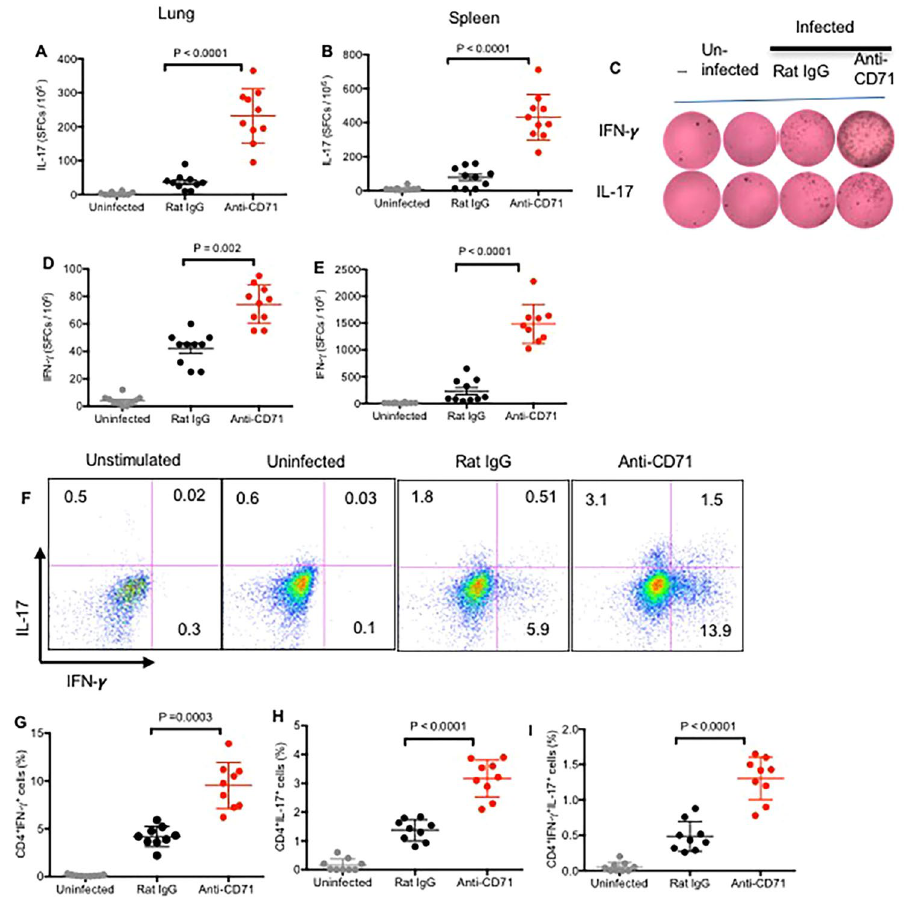
Figure 3. Depletion of CD71 + cells enhances IL-17 and IFN- γ secretion by adaptive immune cells. (A ) Lung cells or ( B ) splenocytes (5 × 10 4 ) from anti-CD71 treated or control mice were stimulated with medium alone or with HKBP for 24 h, IL-17 secreting cells were visualized and enumerated by ELISpot. ( C ) Representative ELISpot images are shown. ( D ) Lung cells or ( E ) splenocytes (5 × 10 4 ) from anti-CD71 treated or control mice were stimulated with medium alone or with HKBP for 24 h, IFN- γ secreting cells were visualized and enumerated by ELISpot. ( F ) Representative plots showing IL-17 and IFN- γ producing CD4 + T cells among splenocytes following stimulation with HKBP for 6 h. ( G ) Percent CD4 + T cells secreting IFN- γ , H, secreting IL-17 and ( I ) secreting IFN- γ and IL-17 following stimulation with HKBP for 6 h. Each point represents data from an individual mouse, representative of three independent experiments. Bar, mean ± one standard